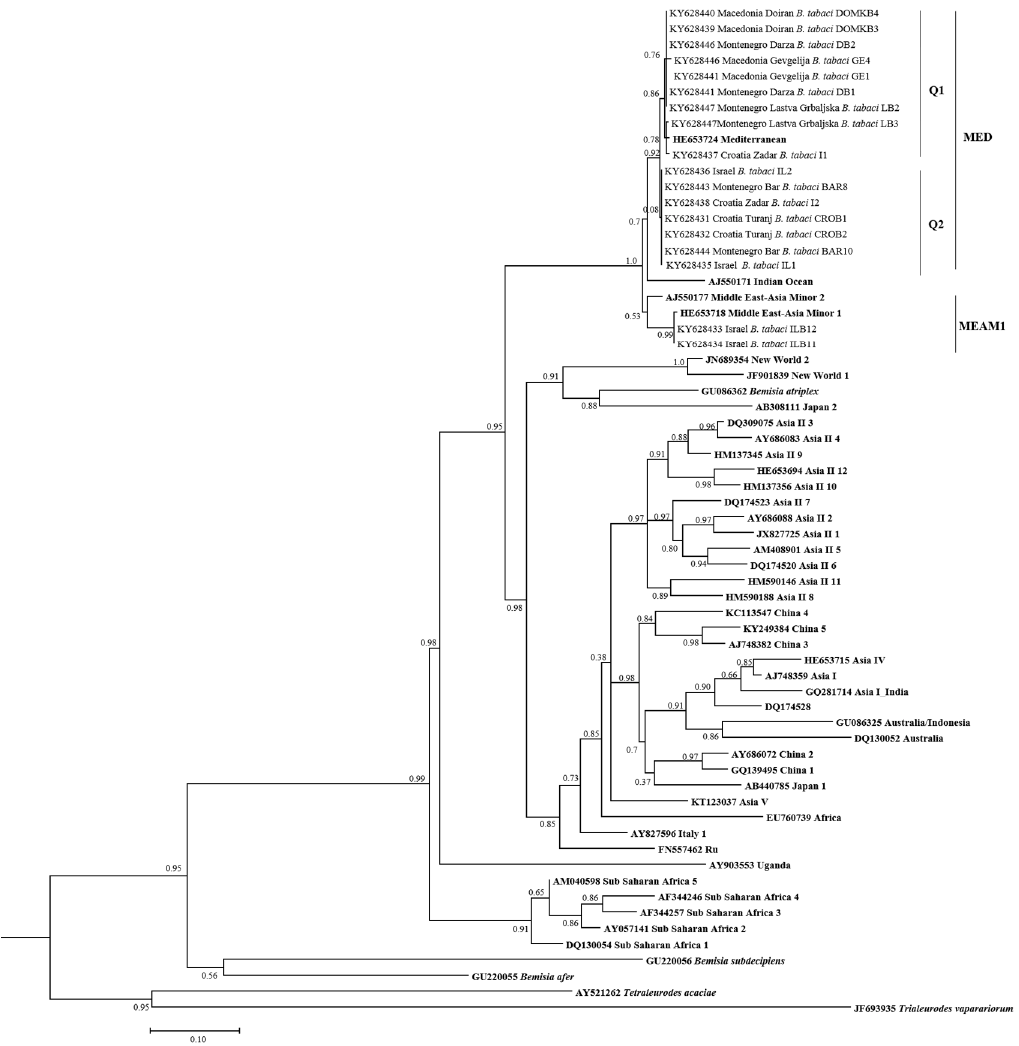
Figure 2. Phylogenetic tree based on the Bayesian analysis of 657 bp of mtCOI gene sequences of Bemisia tabaci populations. Sequences from GenBank are indicated in bold, while those obtained in this study are rearranged based on the geographical origin of B. tabaci individuals. Posterior probabilities are indicated at nodes.